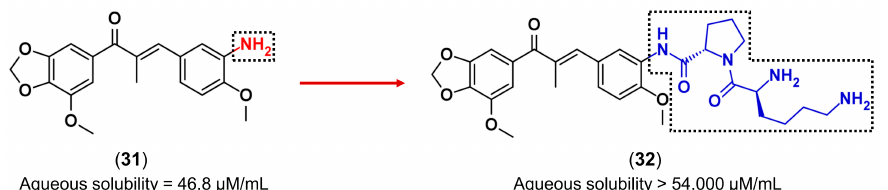
Figure 11. Latentiation represented by the replacing the amine (red) with an L -Lysine- L -Proline (blue) [78].